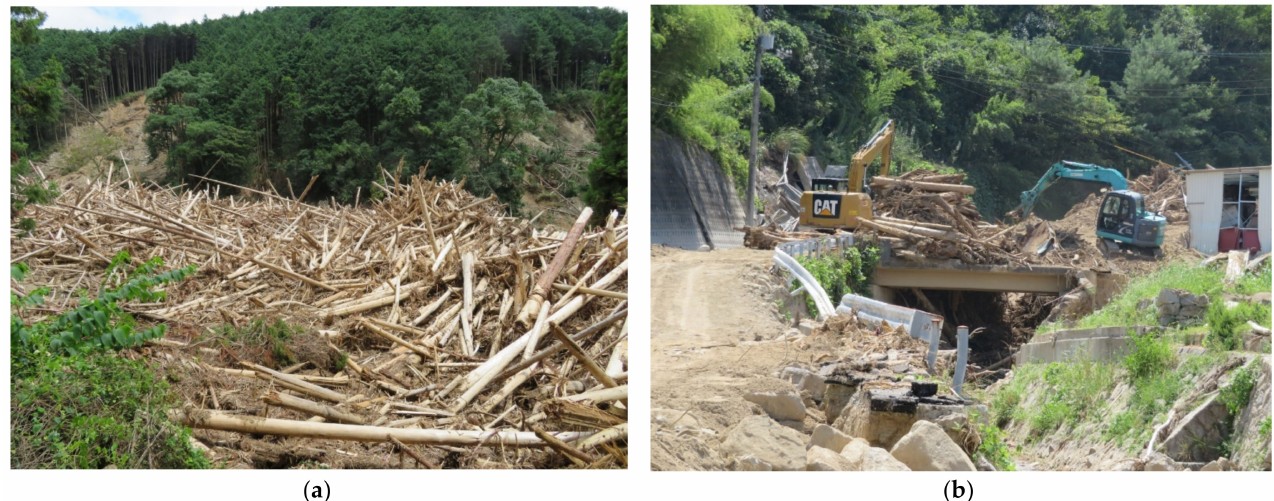
Figure 1. ( a ) A large amount of LW that accumulated in Asakura City (Fukuoka Prefecture) during heavy rainfall in northern Kyushu in 2017; ( b ) LW blocking the bridge over a small river during heavy rain in Hiroshima Prefecture in 2018 (The photo shows the blocking LW being removed).